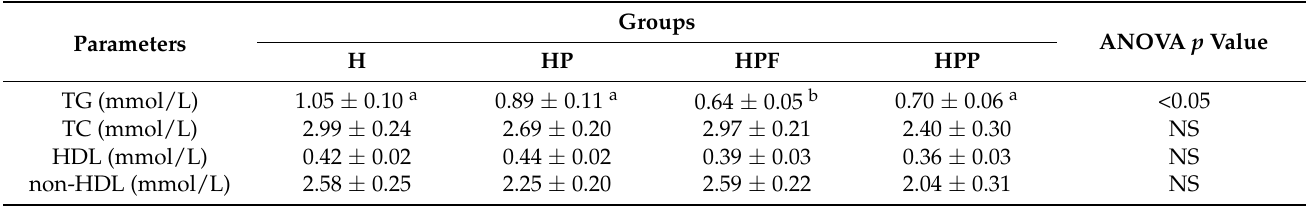
Table 3. Plasma lipid profile of rats fed the experimental